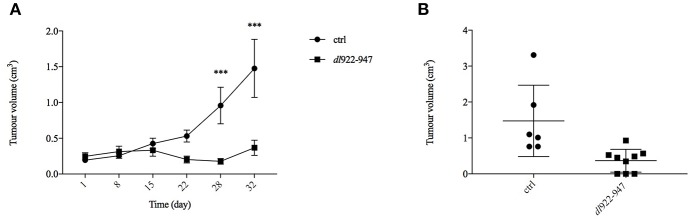
dl922-947 inhibits the growth of MPM xenografts. Mice were subjected to intra-tumoral injections with dl922-947 (4 × 106 pfu) twice per week for a total of 5 weeks. (A) The days of treatment are reported; a significant difference (***p < 0.001) in tumor growth was observed at day 28. (B) Dot plot reporting the xenograft volumes at the final endpoint (32nd day of treatment). Three animals from the control group were sacrificed earlier because tumors were either too big or ulcerated, whereas 3 mice in the treated group showed complete tumor regression.